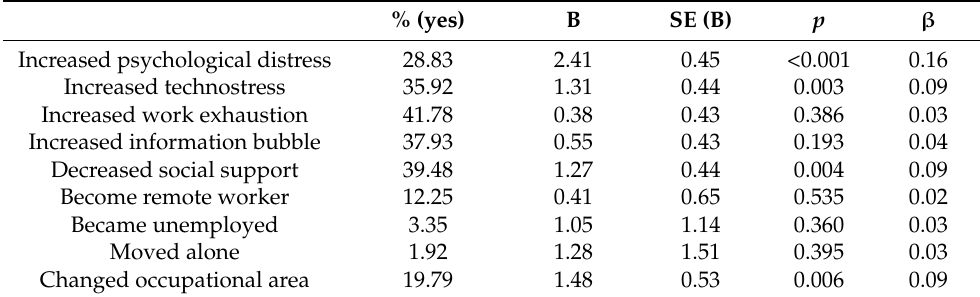
Table 3. COVID-19 anxiety predicted by changes from pre-COVID-19 situation to current. % (yes) B SE (B) p